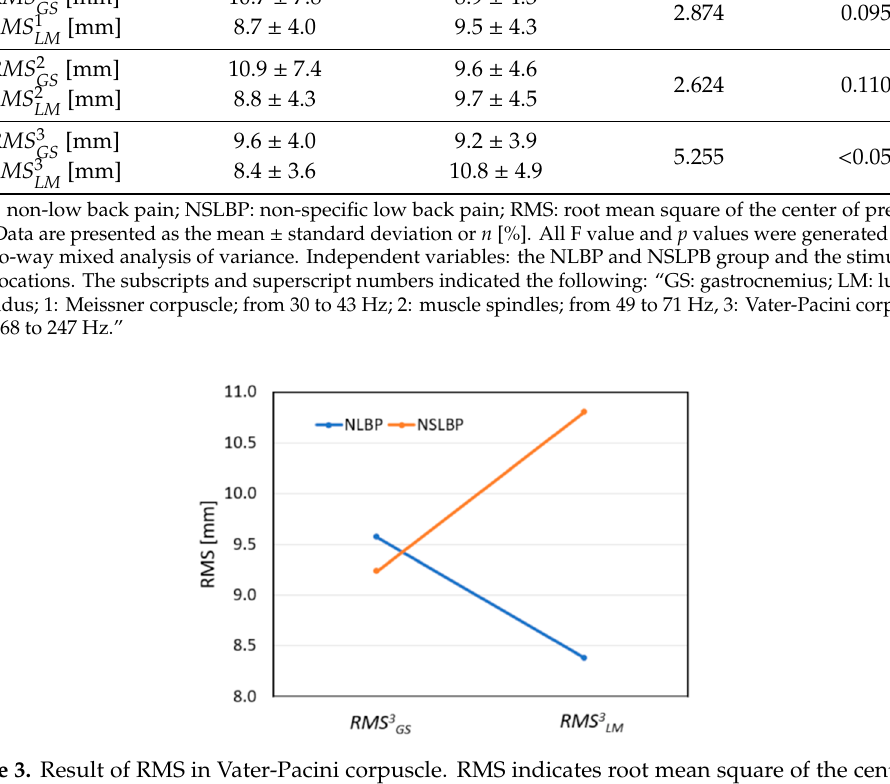
Figure 3. Result of RMS in Vater-Pacini corpuscle. RMS indicates root mean square of the center of